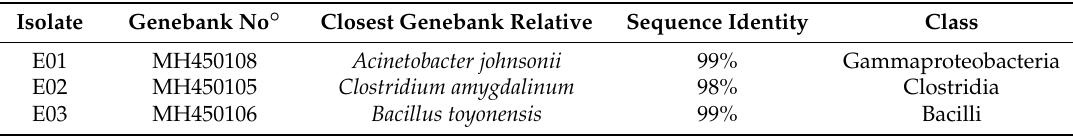
Table 2. Identification of bacteria isolated from the sub-surface intertidal zone of the River Dee estuary.